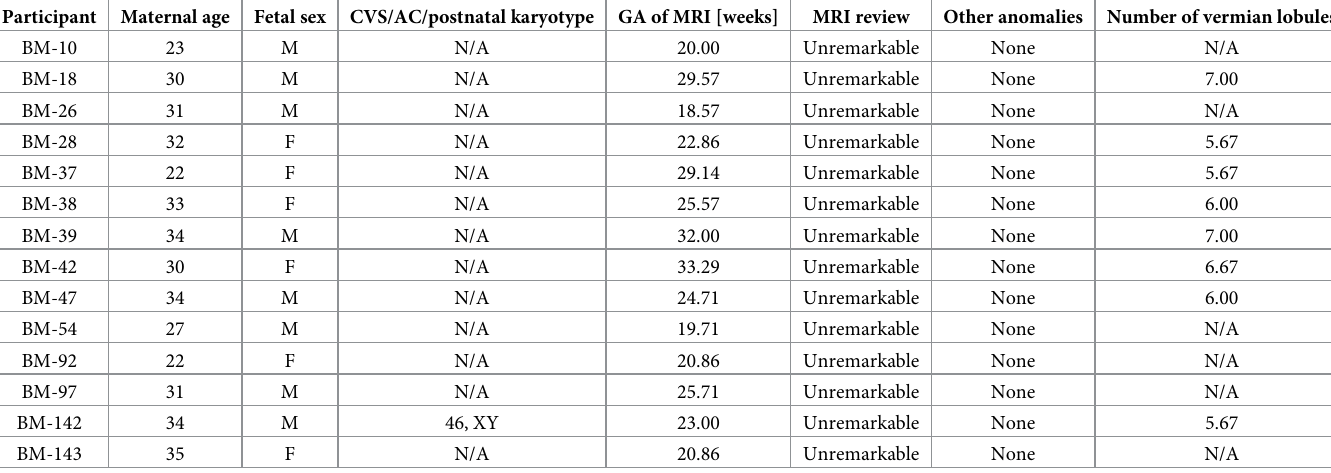
Table 2. Demographics of control